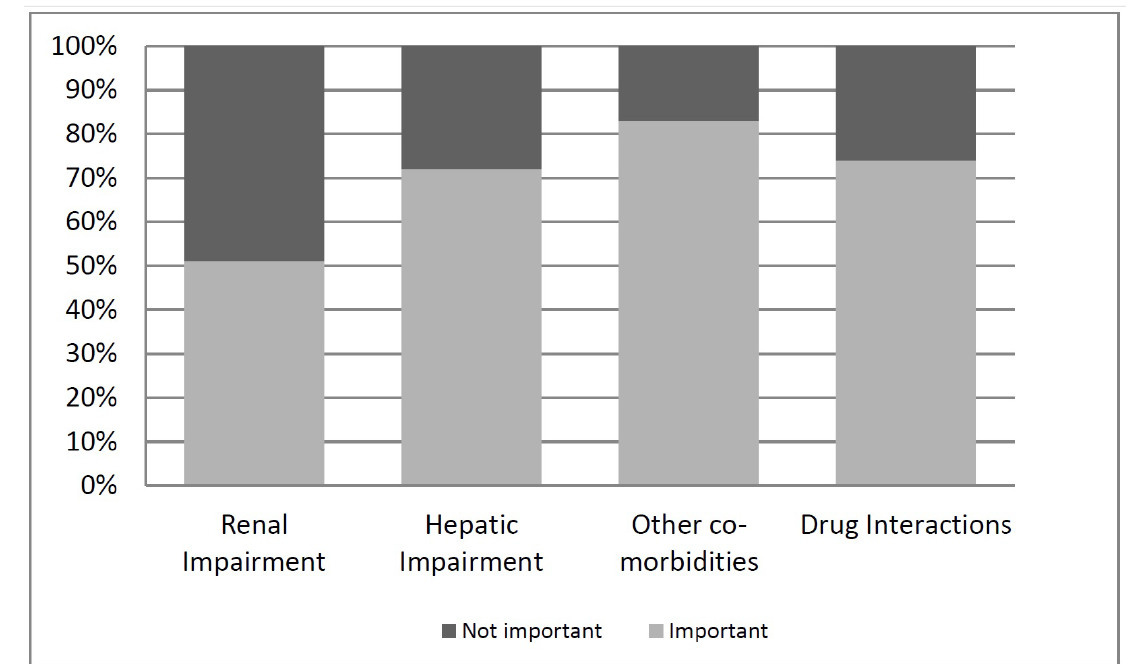
Figure 1. Respondents Ranking of Risk Factors when Prescribing